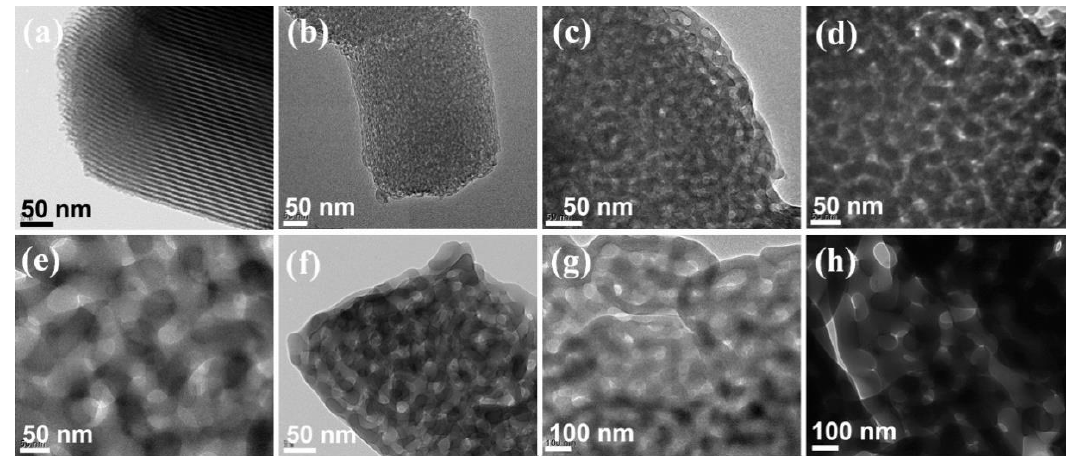
Figure 3. SEM images of ( a ) SBA-15, ( b ) SBA15-Na-80-700, ( c ) SBA15-Na-60-700, ( d ) SBA15-Na-50-700, ( e ) SBA15-Na-40-700, ( f ) SBA15-Na-30-700, ( g ) SBA15-Na-20-700 and ( h ) SBA15-Na-2.1-700.